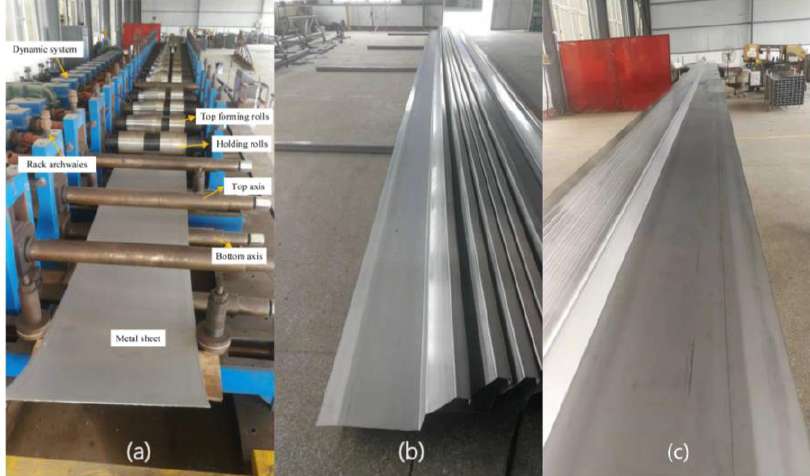
Figure 23. ( a ) The production line of roll forming process; ( b ) and ( c ) final products of metal strip.